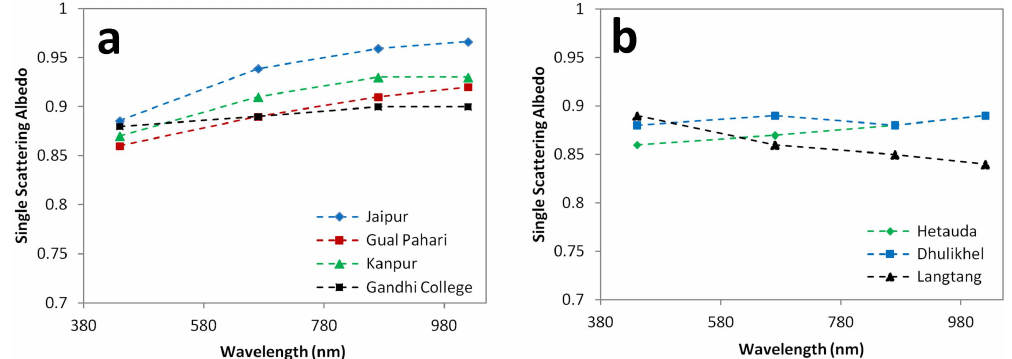
Fig. 10. SSA from AERONET sunphotometers at (a) Jaipur, Gual Pahari, Kanpur and Gandhi College in Northern India, and (b) at Hetauda, Dhulikhel and Langtang of Himalayan foothill/slope regions Nepal. The SSA from AERONET is retrieved at four wavelengths – 440nm, 670nm, 870nm and 1020nm. Values shown are mean SSA for the 2009 pre-monsoon measurement period. Other details including the standard deviation of SSA are given in Table 2 and information of measurement sites (coordinates, elevation) is given in Table